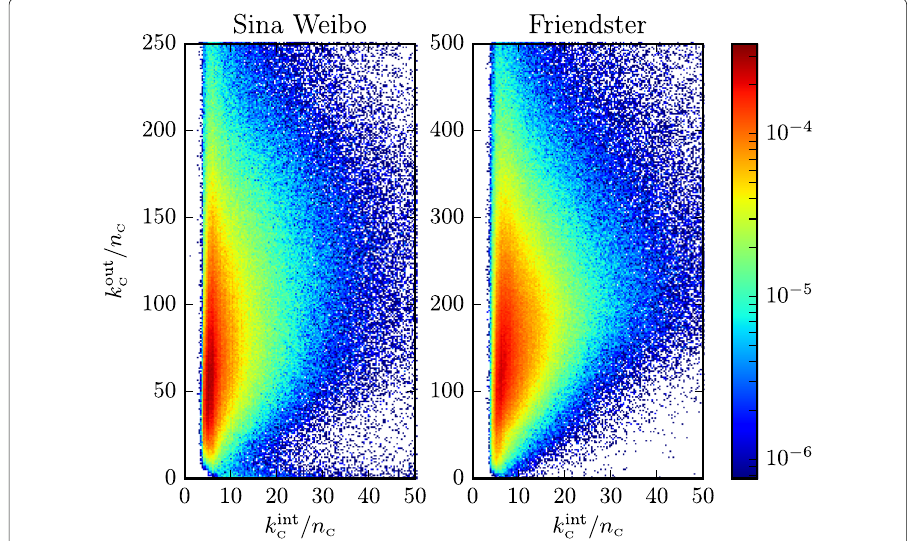
Fig. 4 Histogram of communities grouped by the average internal and outbound edges per member. The numbers of bins in the x and y axes are 200 and 400, respectively. The counting in each bin is normalized by dividing the count by the total number of communities and the bin area. The bin area of the right panel is two times the left panel. To make the normalized values comparable to those in Fig. 6, we set the bin area of the left panel to 1. The normalized counting in each bin is given by the color, as defined by the color bar. > k int , and k out is usually much greater than k int More than 99% of the detected communities have k out C C C